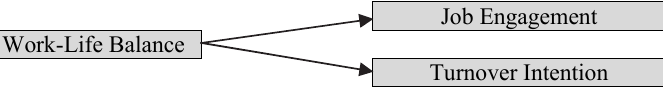
Fig. 1. Research Model